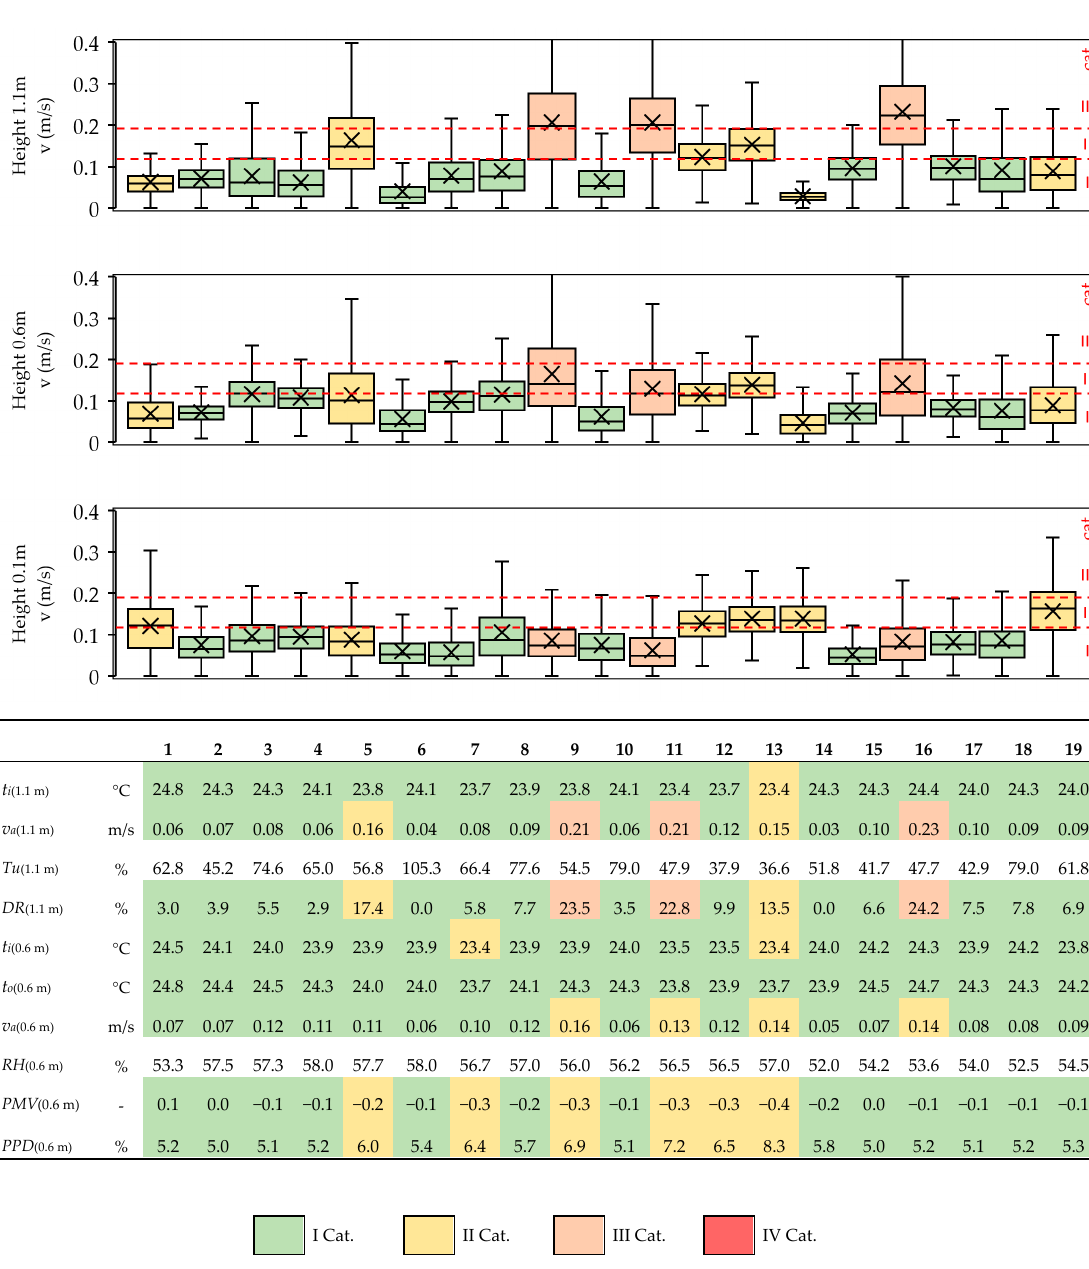
Figure 6. Building C air velocity results in measurement points 1–19 and the thermal comfort Figure6. parameters.